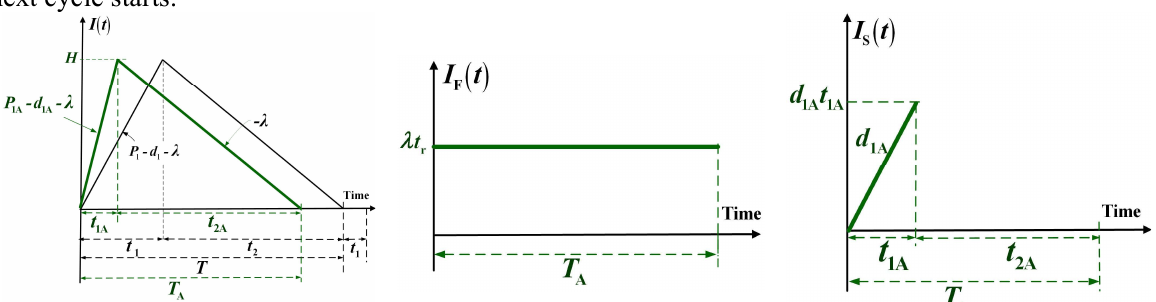
Fig. 4. On-hand stock status in the proposed system with expedited rate and scrap, but without failures taking place (in green) as compared to that of a manufacturing system with scrap (in black)